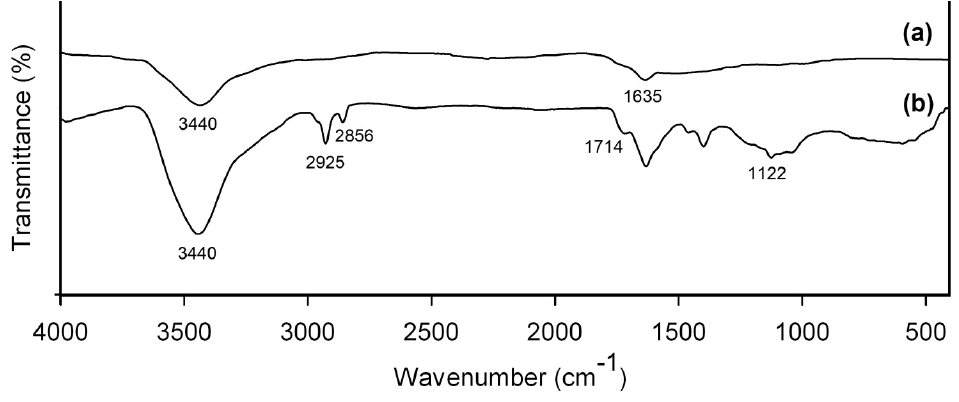
Fig. 5. FTIR spectra of MWCNT (a) and MWCNT-COOH (b).